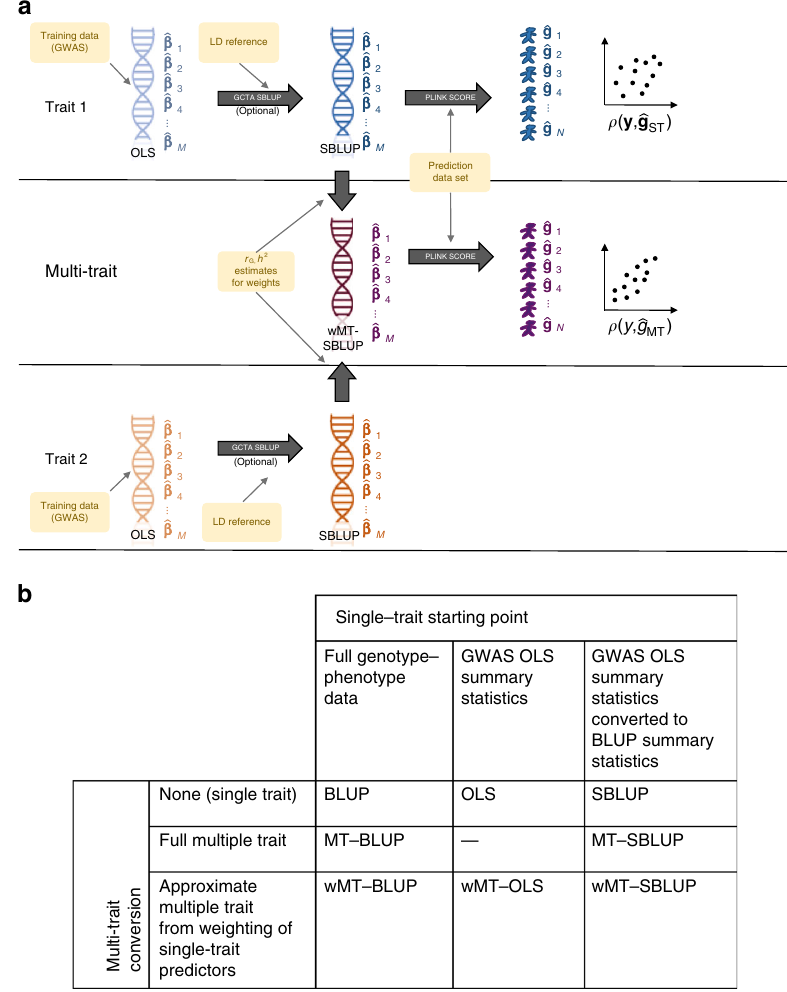
Fig. 1 Schematic of the methods. a Data and programs used to create predictors. b Terminology to refer to different types of predictors. OLS, ordinary least squares. The most common GWAS methodology to estimate SNP effects is to estimate the effect sizes of one SNP at a time using linear regression. BLUP, best linear unbiased prediction. SNP effects are estimated simultaneously for all SNPs. The estimates depend on the other SNPs included in the analysis, since the contribution from correlated SNPs will be shared between